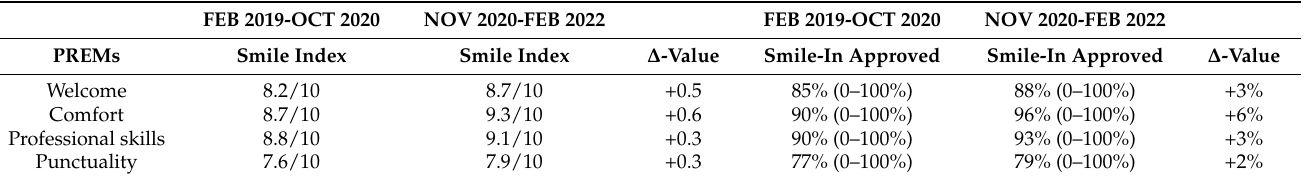
Table 2. Data analysis related to the period before and after one LINAC decommissioning.